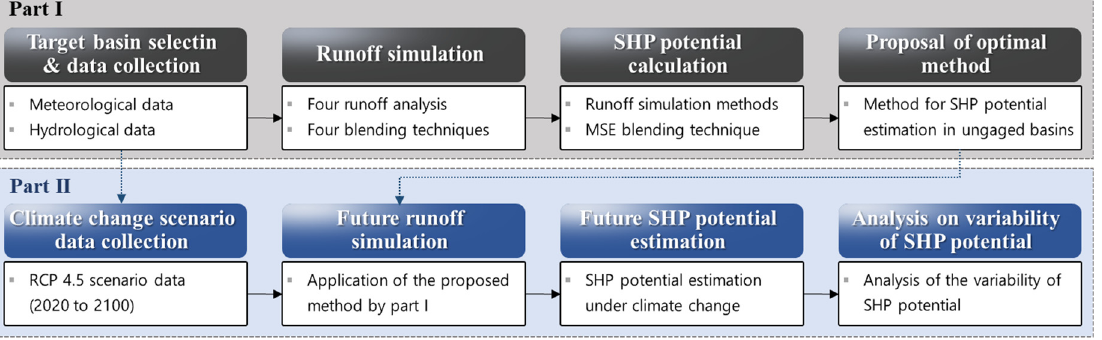
Figure 1. The flowchart of the serial study.